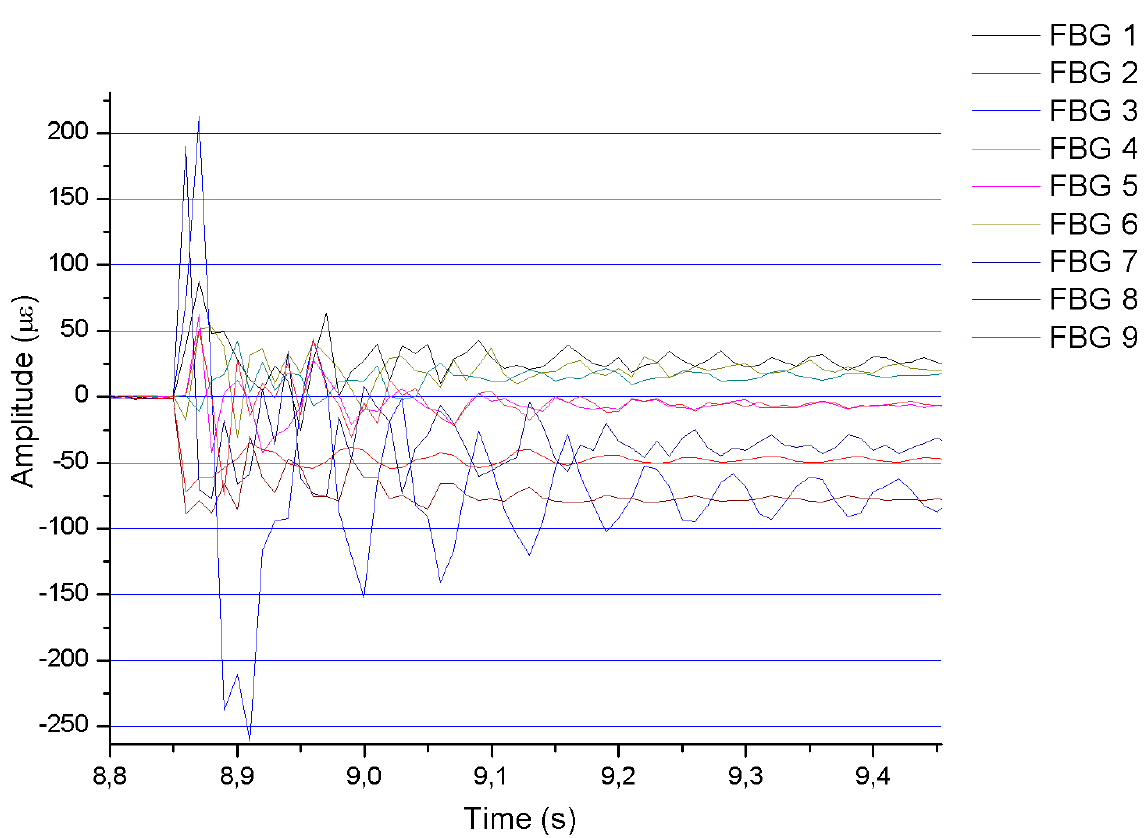
Figure 7. Detail of a chart containing the data resulting from an impact of 4.9 J (Test 8) at impact point